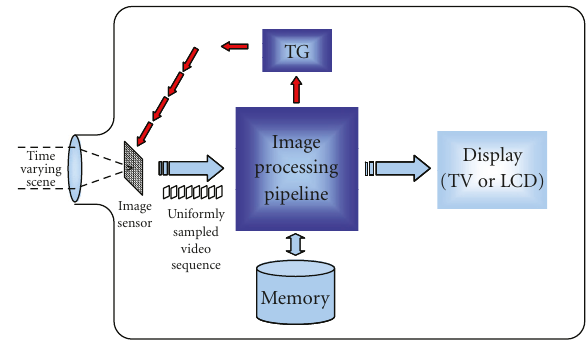
Figure 1: Schematics diagram of a typical digital camcorder.